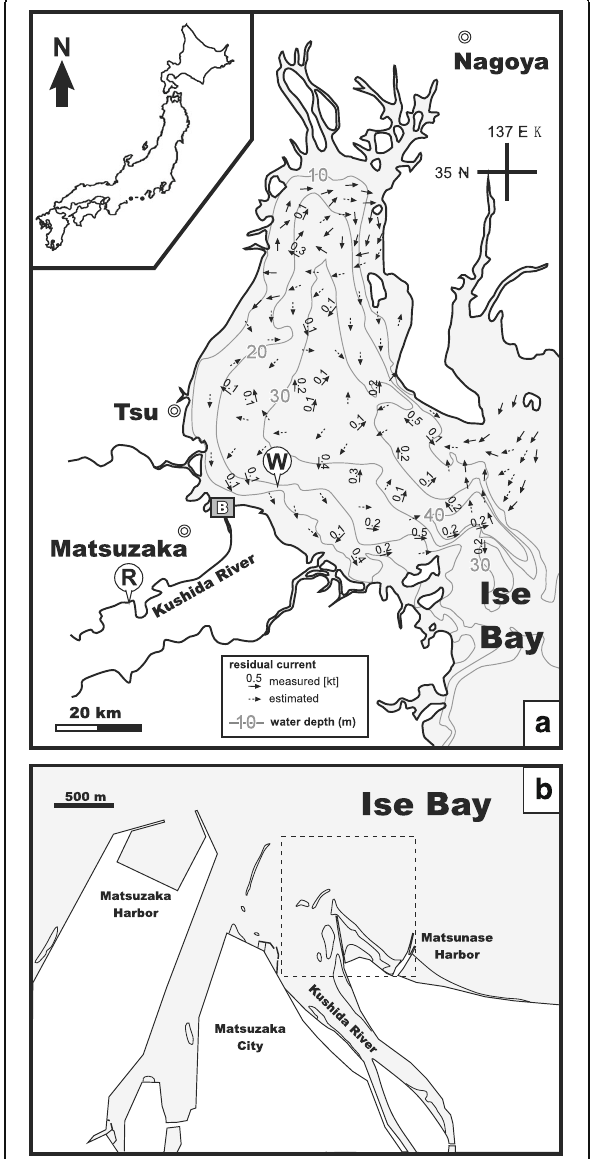
Fig. 1 Index map showing locality of the study area. The data of the residual current velocity (in a ) are from the Coastal Oceanography Research Committee, The Oceanographic Society of Japan (1985). ‘ R ’ and ‘ W ’ (in a ) are measurement localities of rainfall and water depth, respectively. Data are from the Japan Meteorological Agency (JMA) (see Fig. 10; http://www.data.jma.go.jp/obd/stats/etrn/index.php). Details of the geomorphological features of the study area (dotted line in b ) are described in Fig.